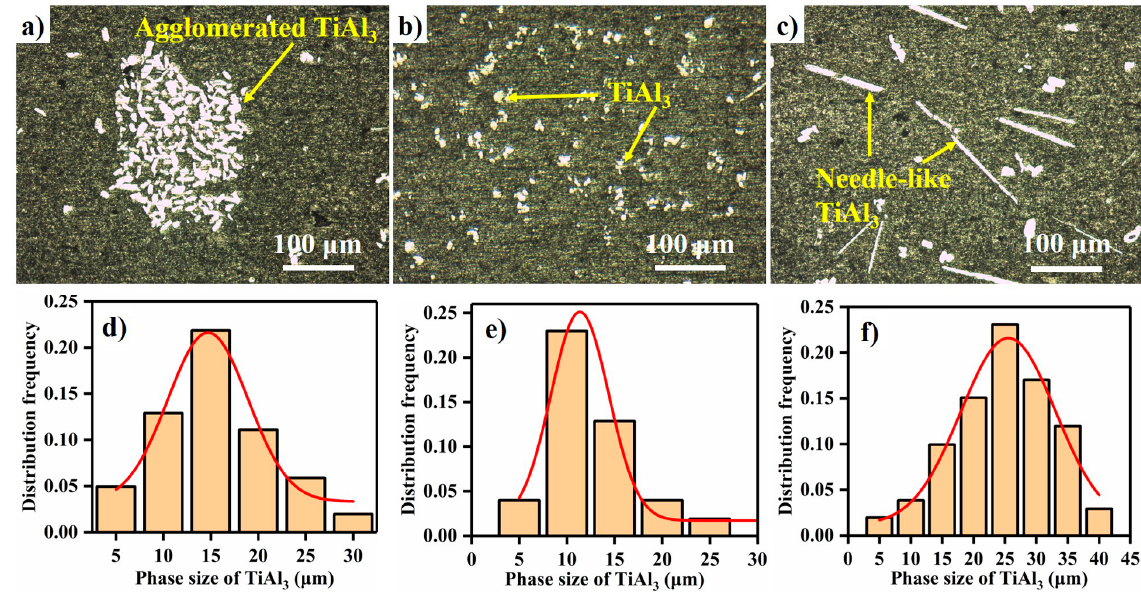
Figure 4. Microstructures of FW-1 at temperatures of: ( a ) 1223 K, ( b ) 1273 K, and ( c ) 1373 K, under the reaction time of 60 min; and ( d )–( f ) the size-distribution frequency statistics of TiAl 3 , corresponding to temperatures of 1223 K, 1273 K, and 1373 K, respectively.